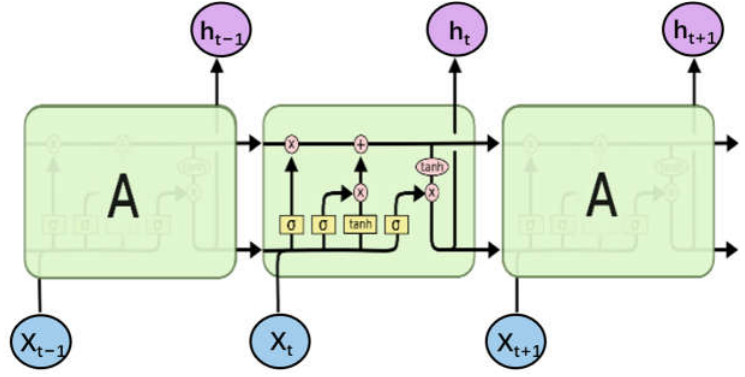
Figure 2. LSTM Structure.